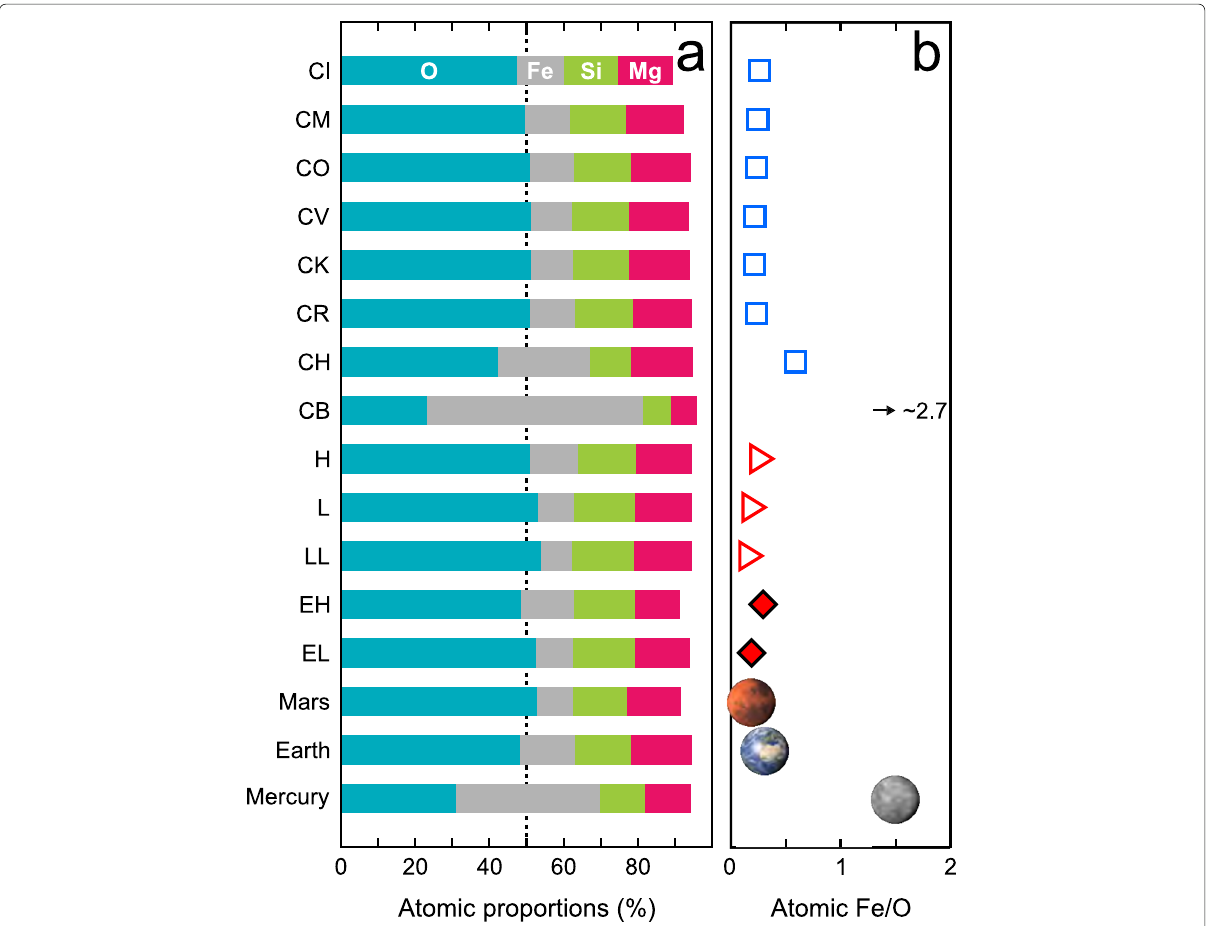
Fig. 1 a Atomic abundances of major elements and b Fe/O values in the solar system bodies. Data sources: chondrites (Alexander 2019a; 2019b; McCall 1968; Ivanova et al. 2008; Gosselin and Laul 1990; Wasson and Kallemeyn 1990; Bischoff et al. 1993); Mercury (this study); Earth (McDonough 2014); Mars (Yoshizaki and McDonough 2020)